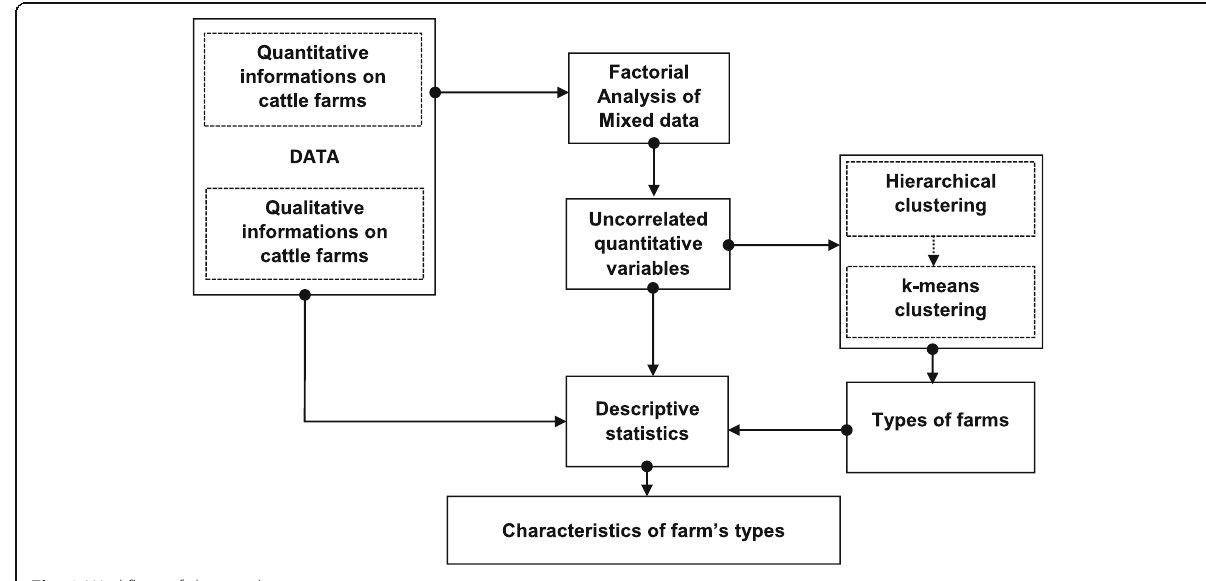
Fig. 2 Workflow of the typology